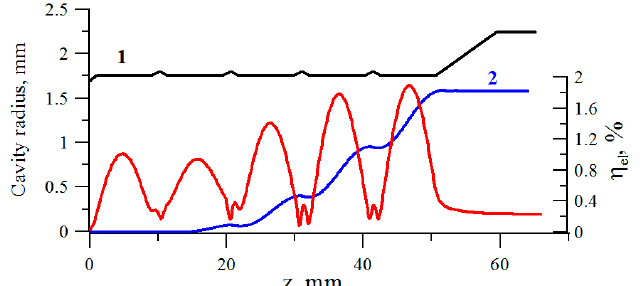
Fig. 3. A gyrotron with a sectioned cavity at the fourth cyclotron harmonic. The optimized cavity profile (curve 1) and the structure of the high-frequency field of the operating TE4.5 mode, as well as the calculated dependence of the electronic efficiency on the longitudinal coordinate (curve 2).